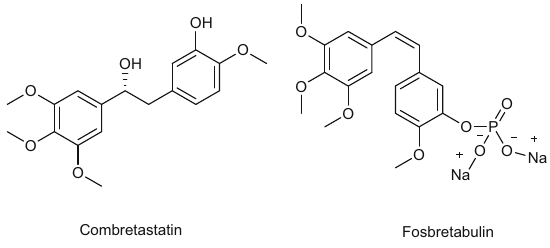
Figure 1: Combretastatin, CA - 4P ( fosbretabulin ) structures.